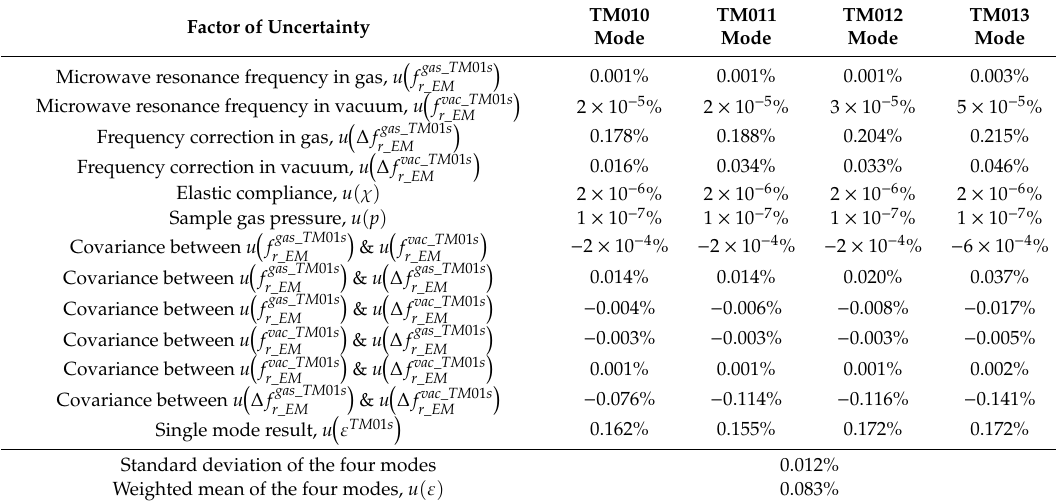
Table 2. Uncertainty budget for the dielectric permittivity measurement at 343 K and 150 kPa. Factor of Uncertainty Microwave resonance frequency in gas, u